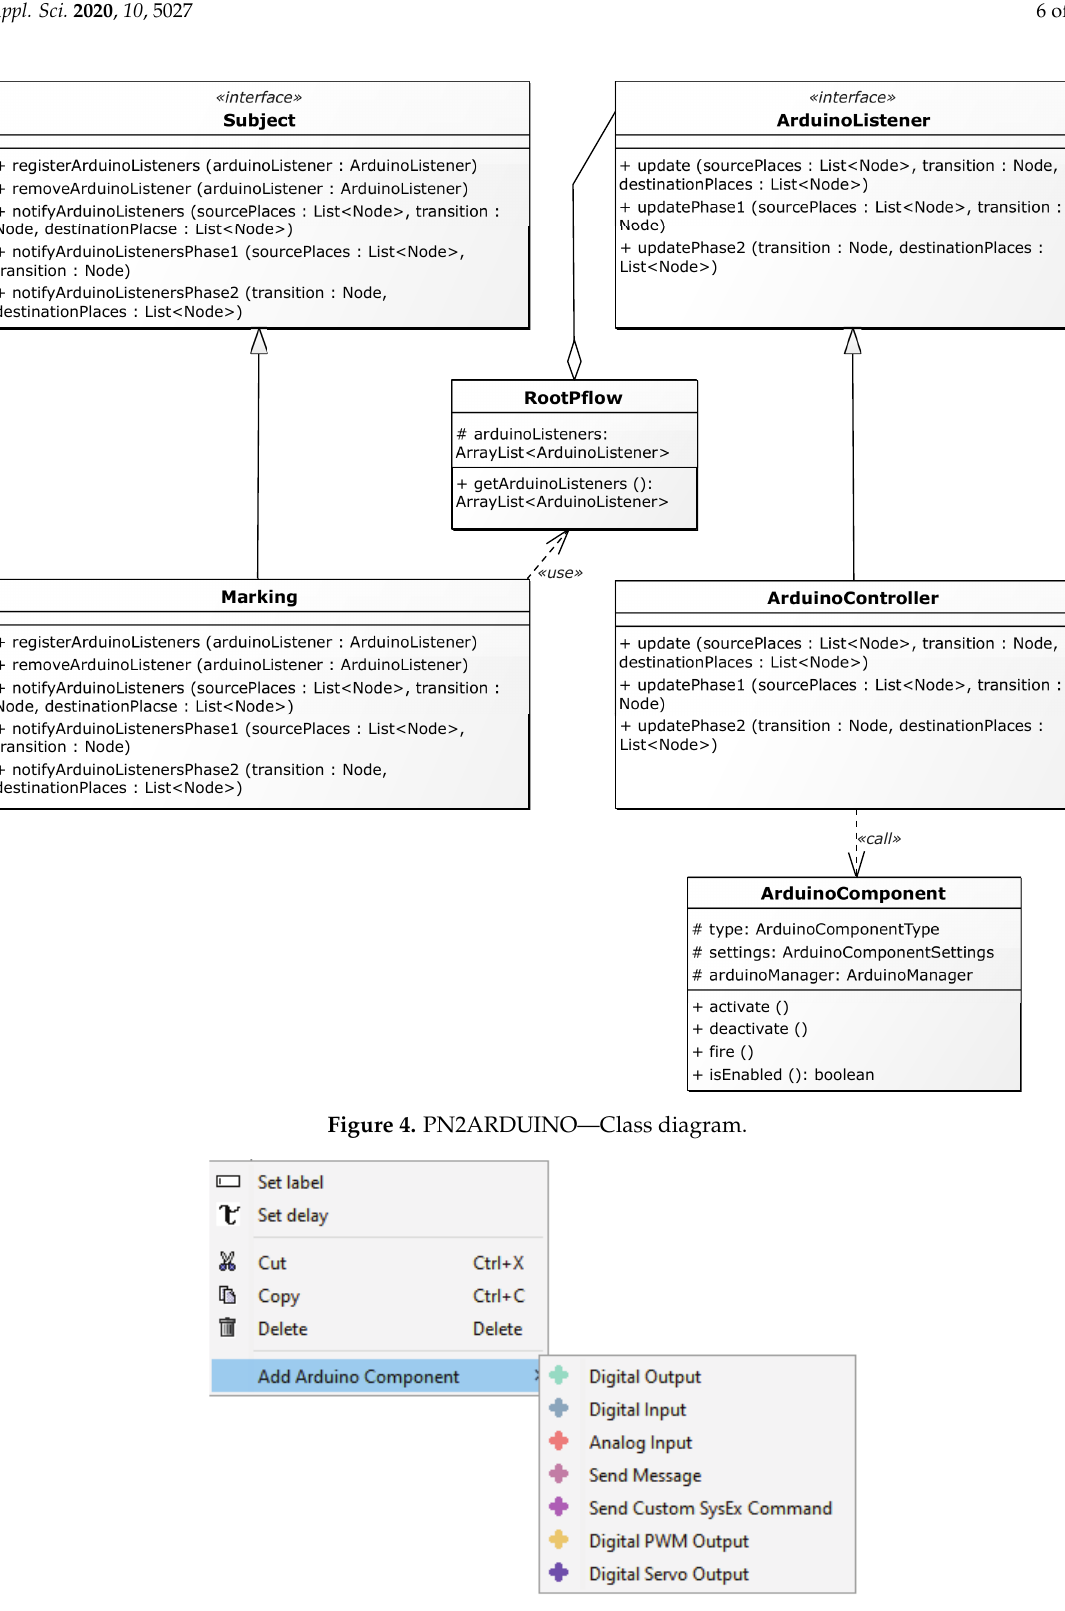
Figure 5. PN2ARDUINO—Adding of Arduino